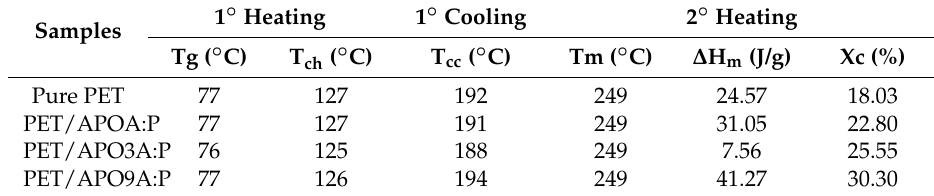
Table 3. Differential scanning calorimetry (DSC) data of pure PET and PET hybrids.